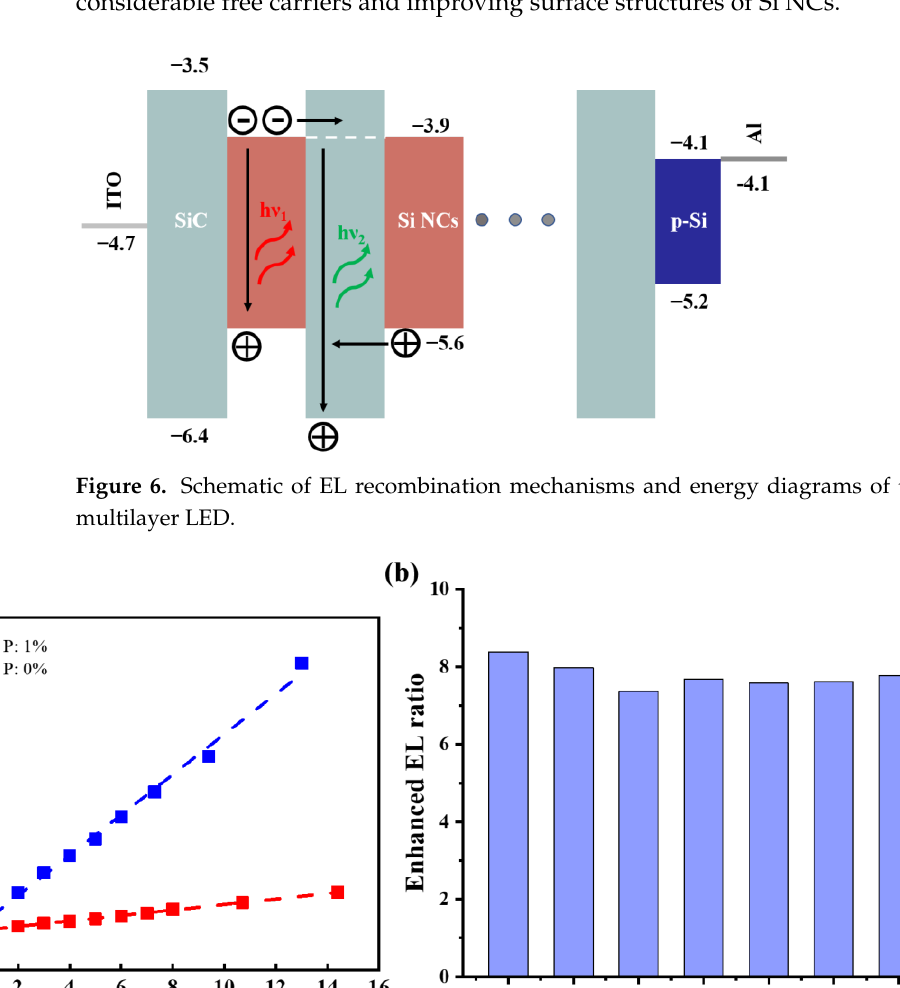
Figure 6. Schematic of EL recombination mechanisms and energy diagrams of the Si NCs/SiC mul- tilayer LED.